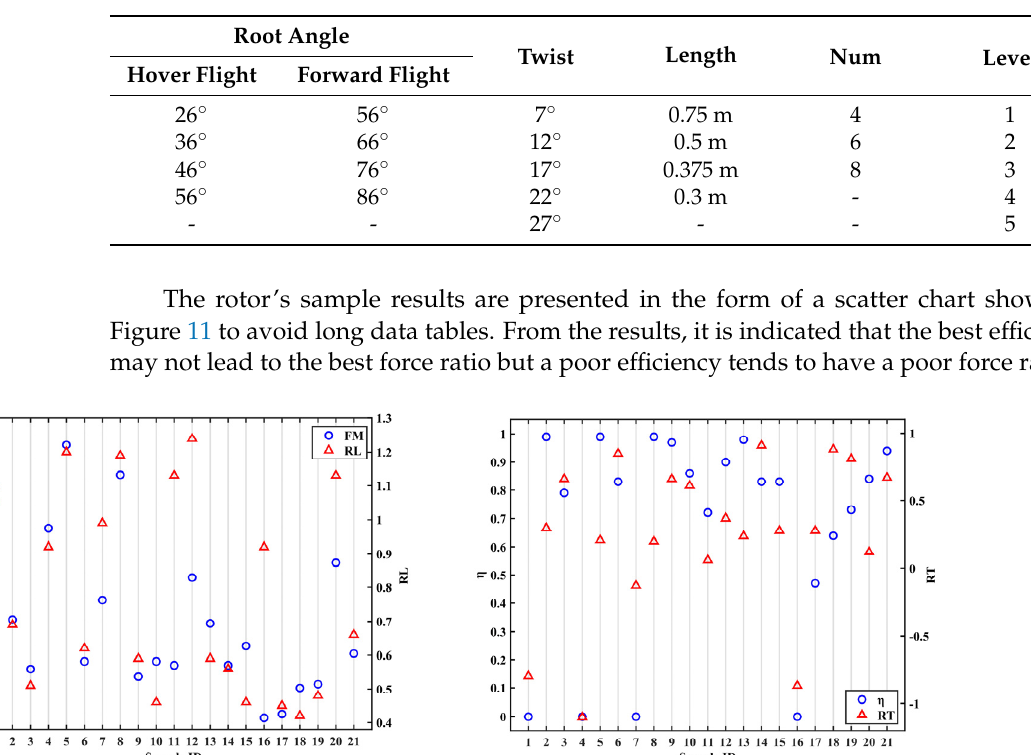
Figure 12. The rotor’s normalized K value curve. ( a ) Hover flight. ( b ) Forward flight. Through the sample calculation, the corresponding four optimal samples of aerody ‐ namic characteristics are acquired according to K values and the combination is obtained. The orthogonal rationality is validated by CFD as shown in Table 6: The three optimal samples reach the expected optimal value, and the deviation of forward flight efficiency may be due to the influence of the duct’s inlet velocity on the blade’s angle of attack (AOA) during forward flight. Table 6. Validation of rotor’s optimal sample combinations. Aerodynamic Characteristics